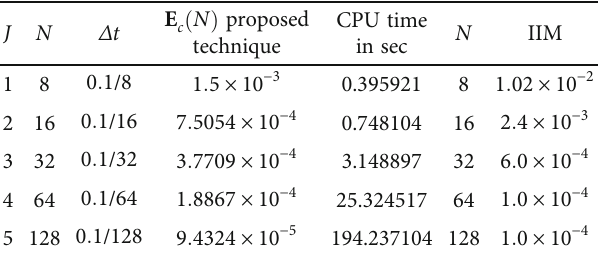
Table 4: Analysis of errors for Example